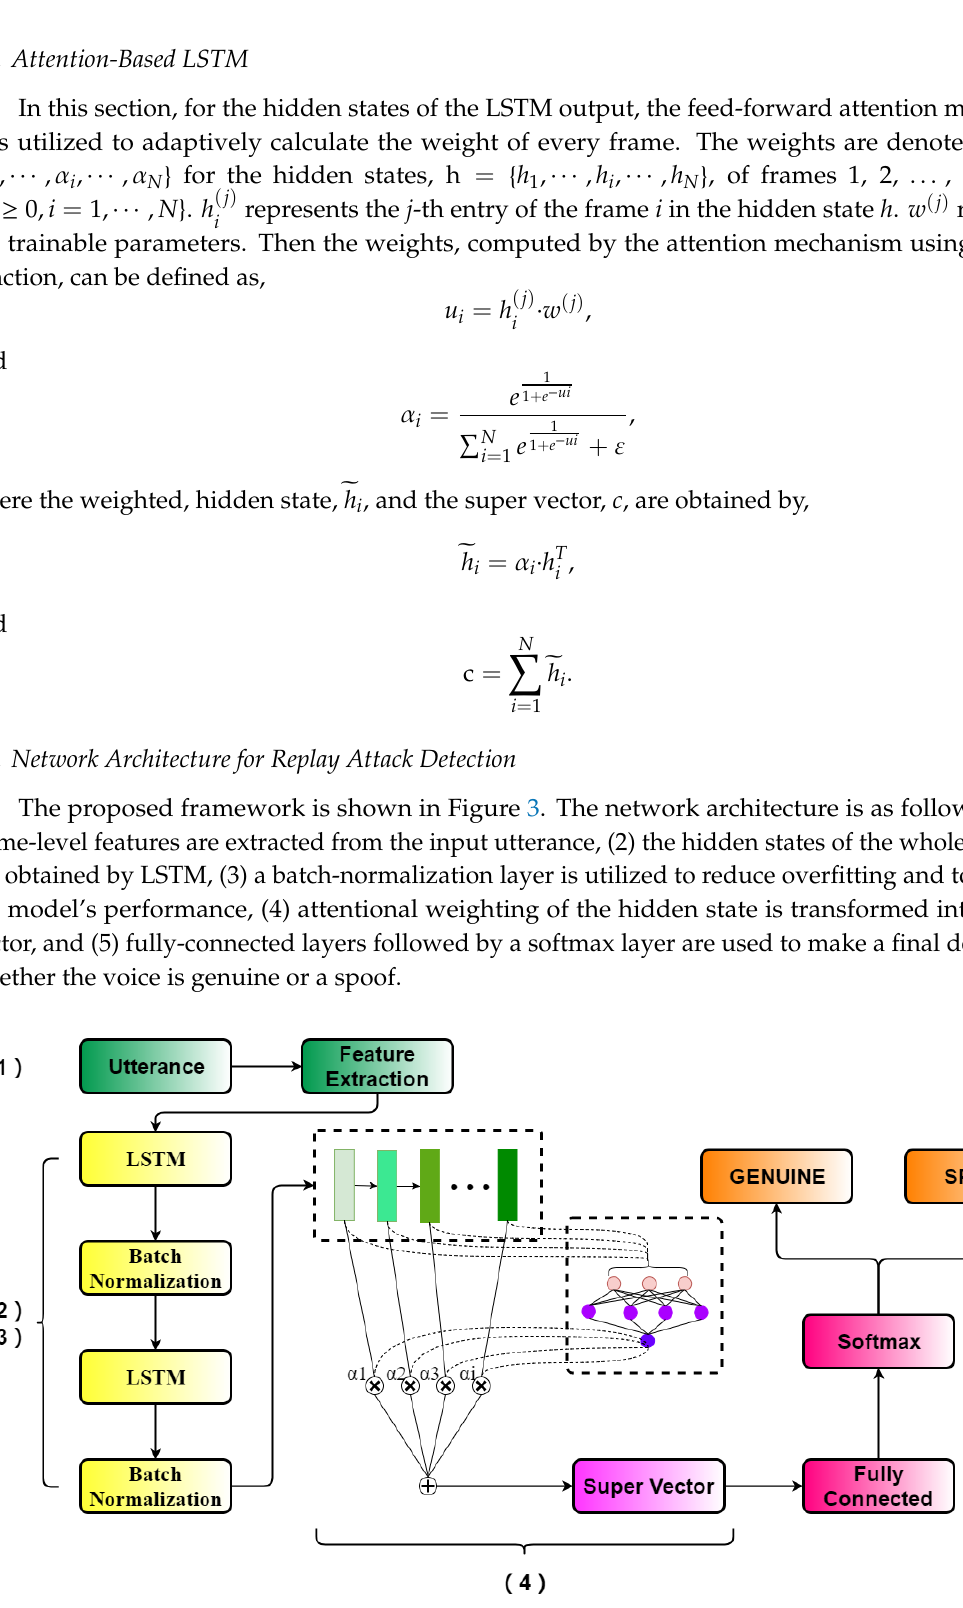
Figure 3. Network architecture for replay attack detection with attention mechanism.